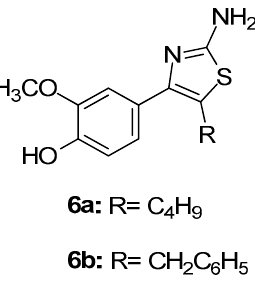
Figure 7. Chemical structures of compounds 6a (N-[4-(4-hydroxy-3-methoxyphenyl)-1,3-thiazol.-2-yl]acetamide) and 6b (4-(2-amino-1,3-thiazol-4-yl)-2-methoxyphenol). Abdelall et al.[17], by modification of the celecoxib molecule, designed and synthesized some thiazolo-celecoxib analogues ( 7a – 7j , Figure 8) and evaluated their anti-inflammatory, COX-1, COX-2 and 15-LOX inhibitory activity.